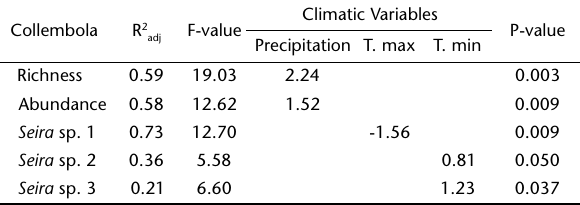
Figure 1. NMDS analysis generated by Bray-Curtis similarity matri-